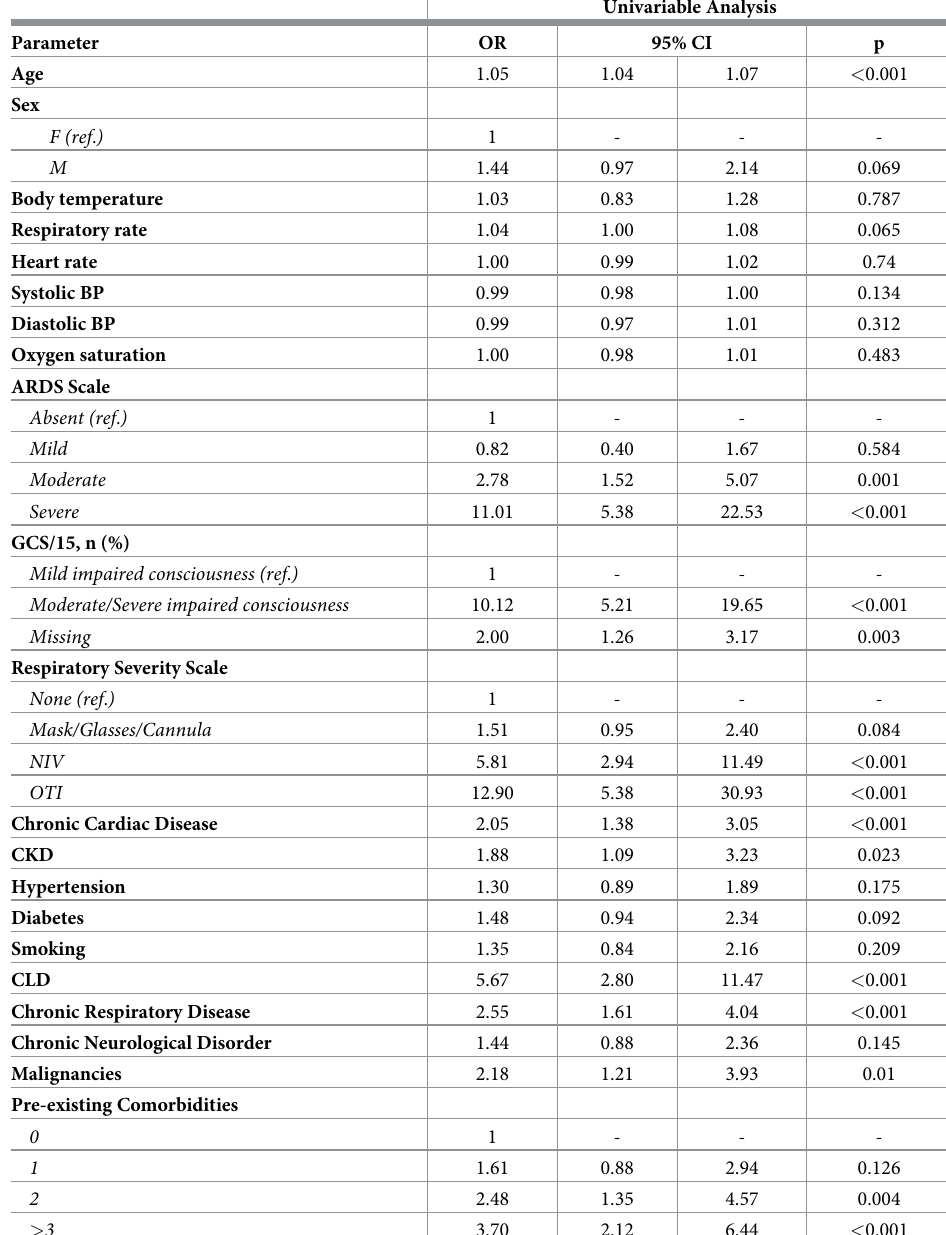
Table 2. Univariable Analysis on mortality outcome of baseline characteristics of study population (n = 618).